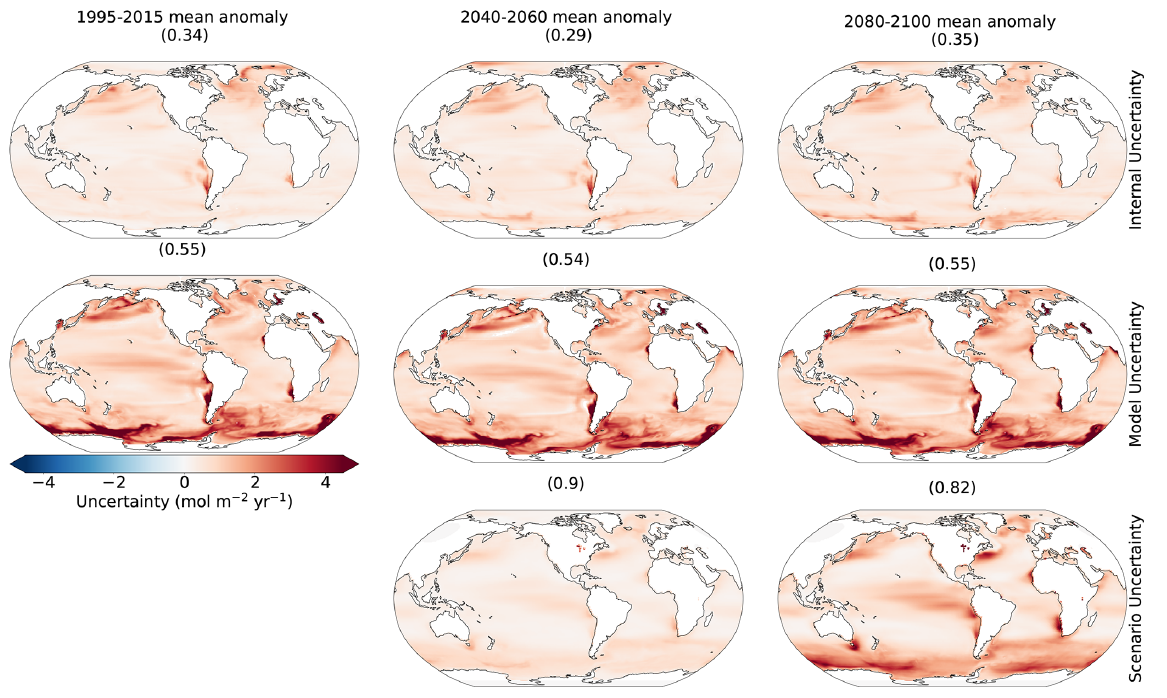
Figure 5. Sources of uncertainty averaged over the 20-year mean periods. The rows represent different sources as explained in the “Data and methods” section at each grid cell. Columns represent different times: the recent (1995–2015), mid-century (2040–2060), and late century (2080–2100) anomalies relative to the 1995–2015 mean. The numbers are correlation coefficients of each map with the 1995–2015 mean anomaly relative to the 1850–1900 mean (Fig.